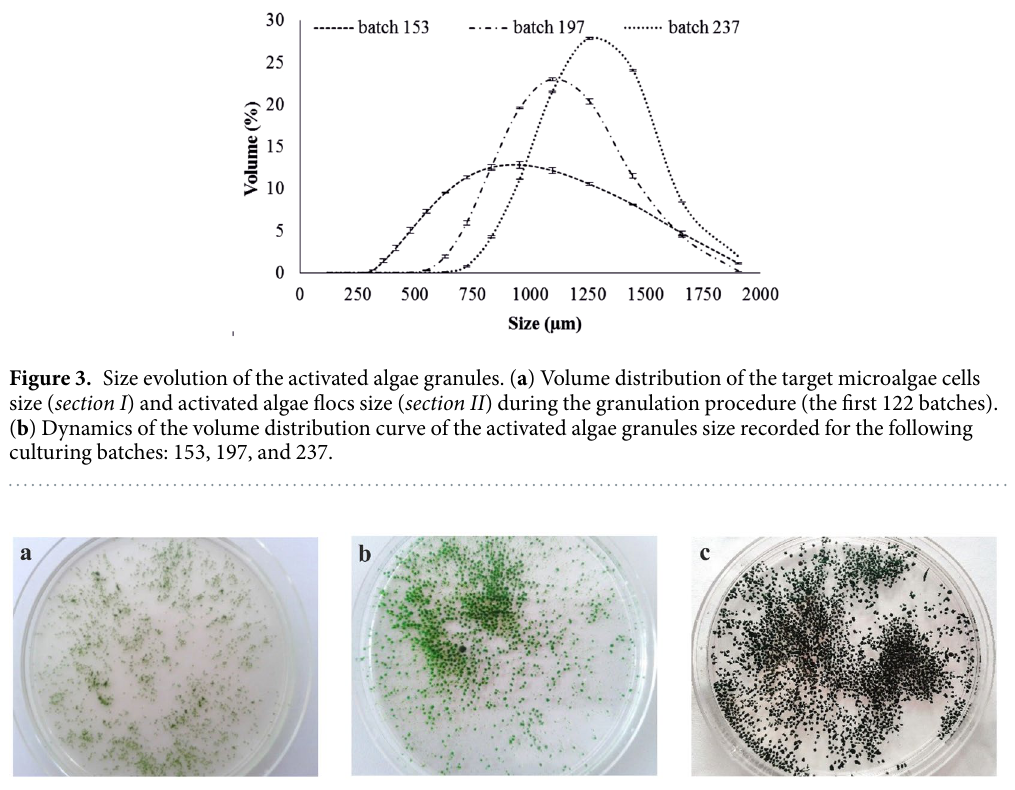
Figure 4. The time development of the granular activated algae system. Activated algae system during granulation process: ( a ) batch 59, ( b ) batch 122, and ( c ) obtained activated algae granules after 197